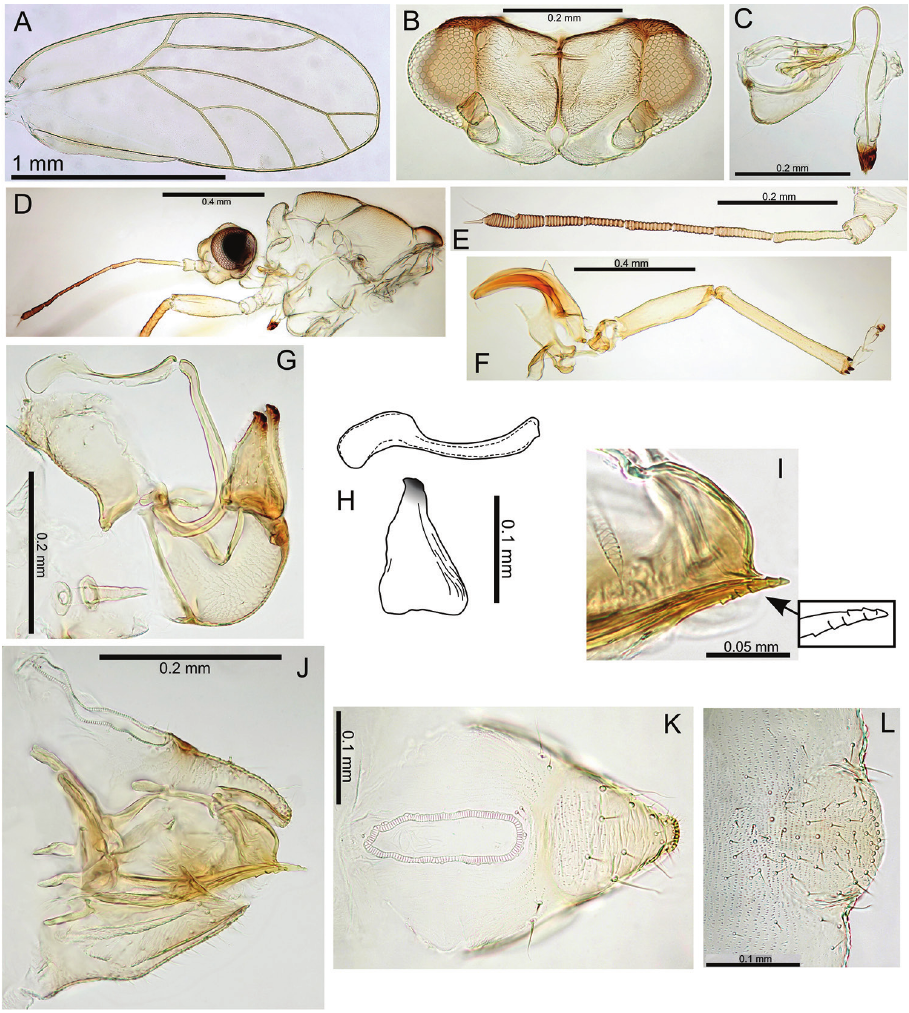
Figure 12. Pariaconus poliahu sp. n. A fore wing B head (female) C proboscis (female) D head and thorax (female) E antenna (female) F hind leg G male terminalia H aedeagus and paramere I oviposi- tor (serrations indicated) J female terminalia K female proctiger (dorsal view) L female subgenital plate (ventral